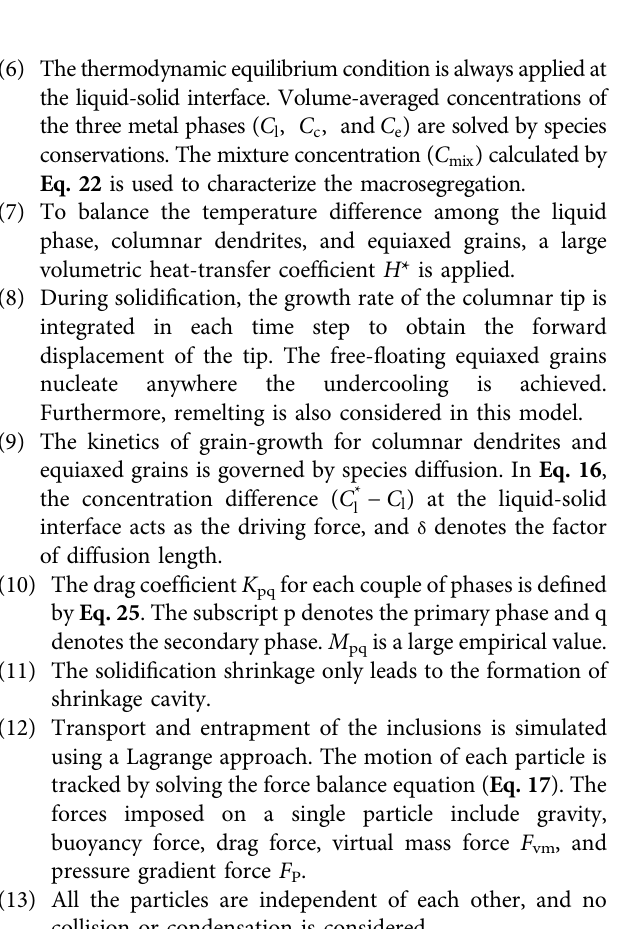
FIGURE 1 | Schematic of the 36-ton steel ingot: (A) ingot and mold dimensions, (B) boundary and initial conditions for simulation.